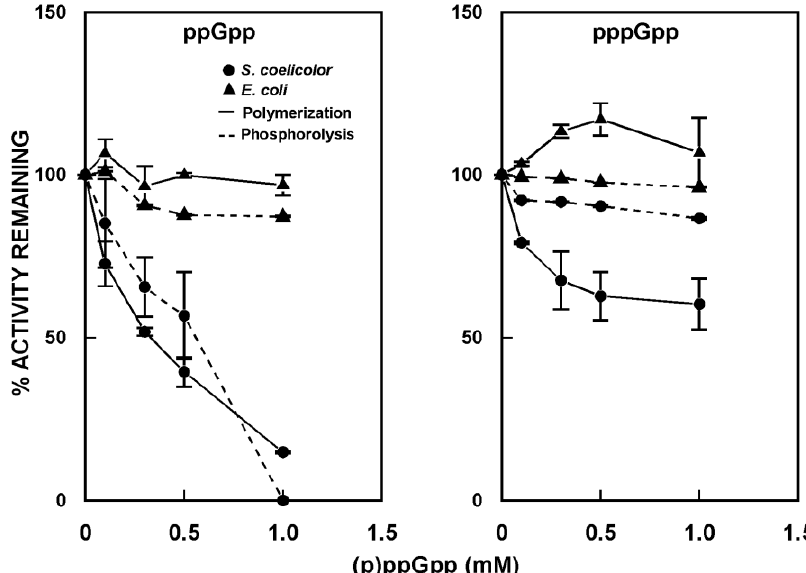
Figure 6. Effects of (p)ppGpp on the activity of PNPase. Polymerization and phosphorolysis reactions were performed in the absence and presence of guanosine tetraphosphate (ppGpp) or guanosine pentaphosphate (pppGpp), using purified PNPase from S. coelicolor and E. coli [59]. Results are expressed relative to the activities measured in the absence of (p)ppGpp, set arbitrarily to 100%.